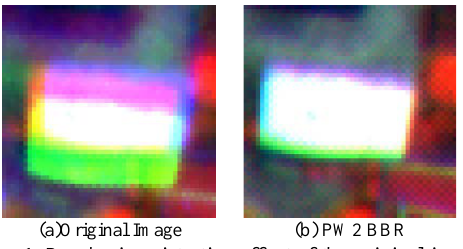
Figure 1. Band misregistration effect of the original imagery and PW2 BBR result (R: 750 nm, G: 550 nm, B: 450 nm)